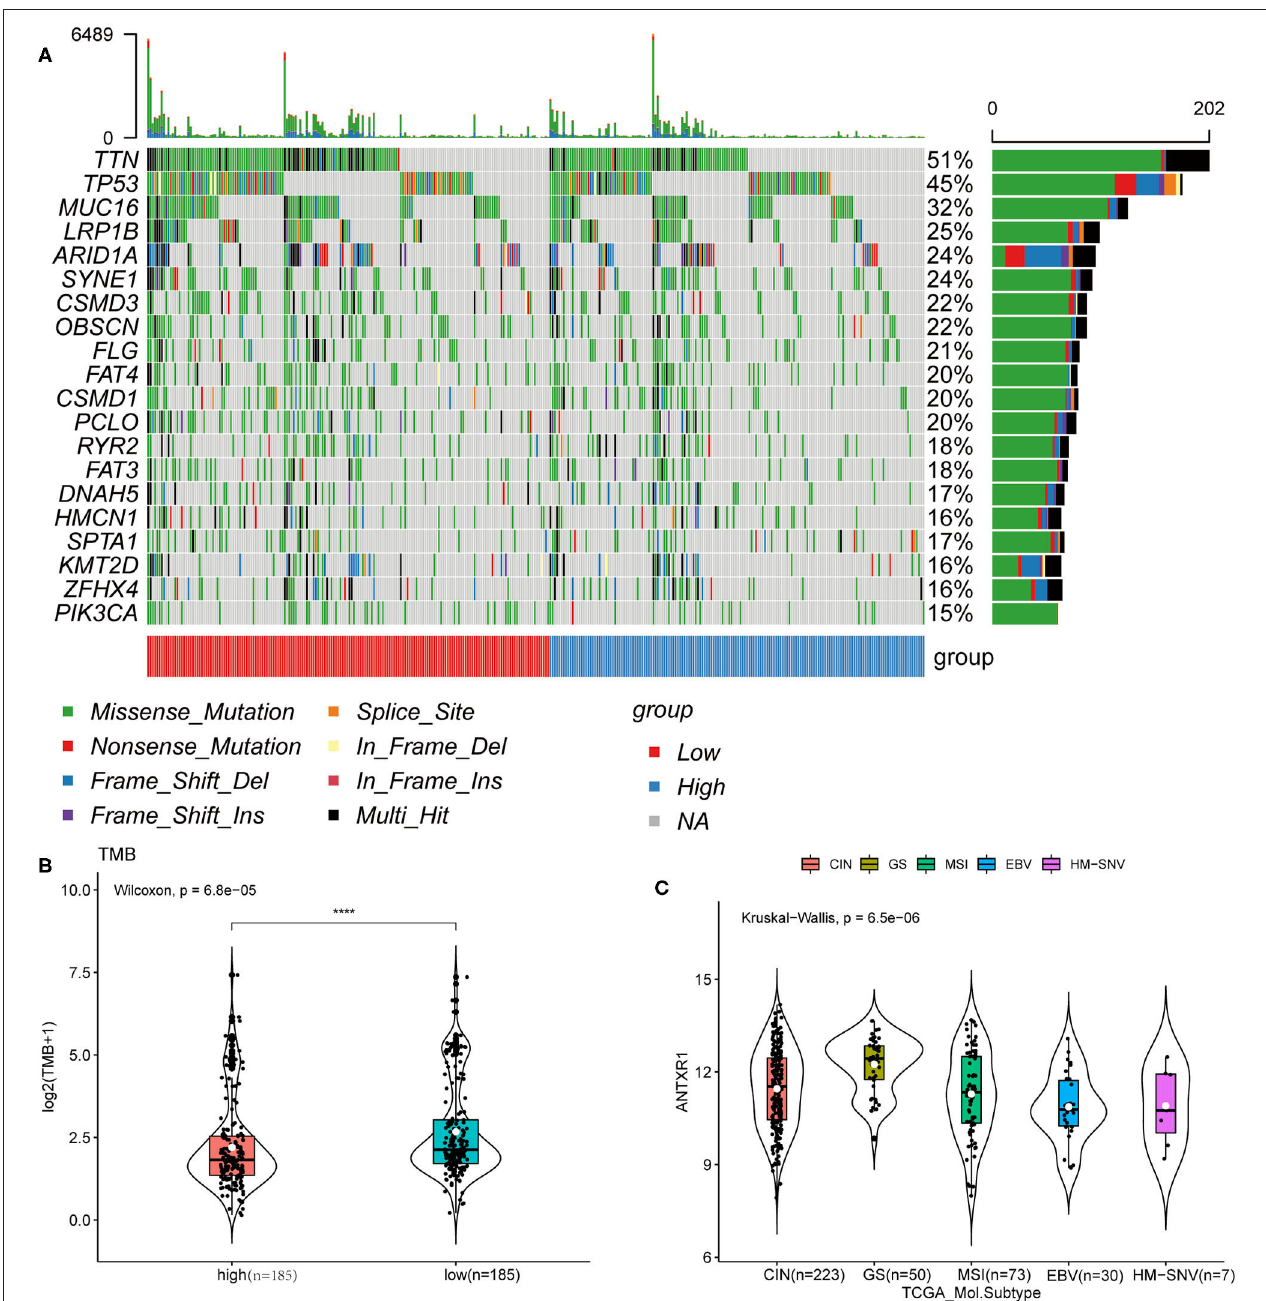
FIGURE 8 | ANTXR1 expression is correlated with TMB in gastric cancer. (A) Distribution of the top 20 variant mutated genes between high ANTXR1 expression and low was shown in the waterfall plot. (B) Association between TMB and ANTXR1 expression. (C) Distribution of ANTXR1 expression levels of TCGA molecular subtypes. Box plot elements (center line, median; box boundaries, upper and lower quartiles; whiskers, maximum and minimum). TMB, tumor mutation burden. **** P <